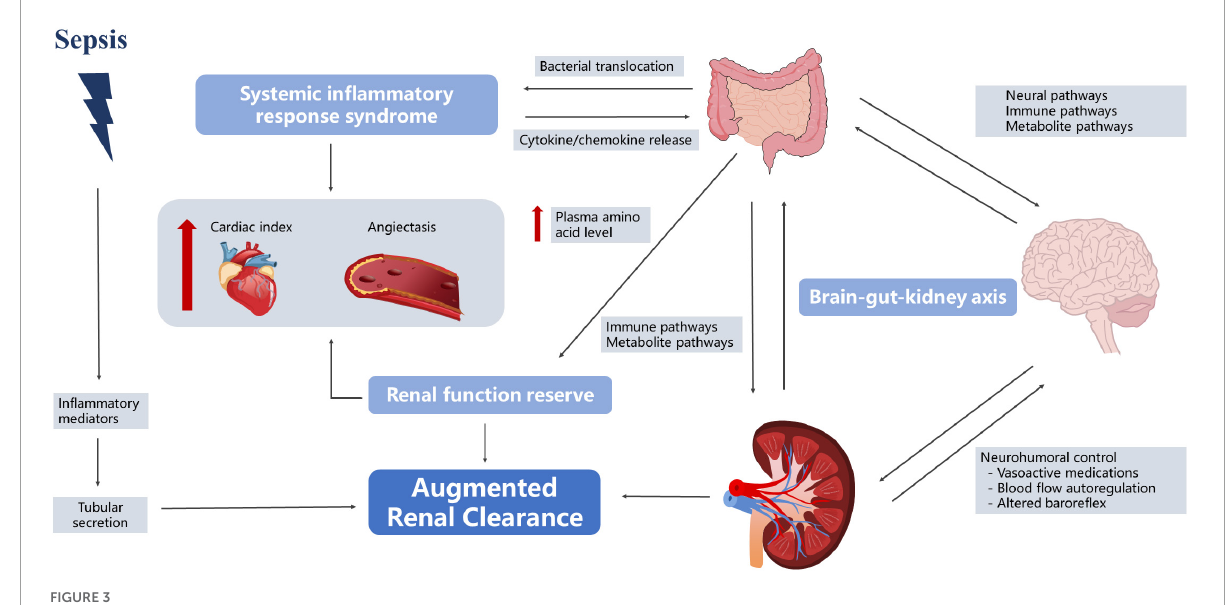
FIGURE3 Roles of the gut microbiota in kidney